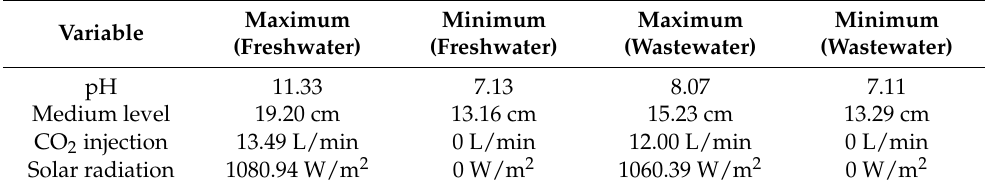
Table 2. Maximum and minimum values from each variable used to normalize the data.